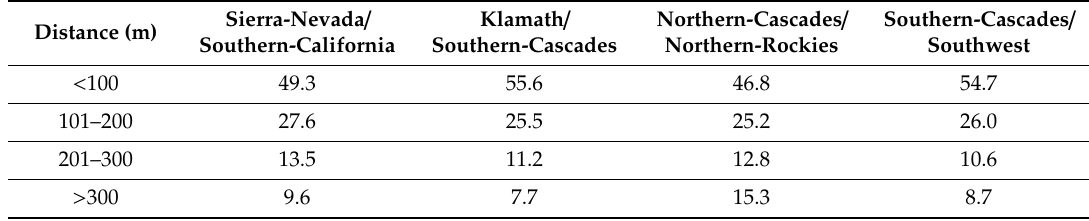
Figure 3. Scatter plot of size of individual large ( > 400 ha) CESF patches, 1984–2015. Table 2. Critical values (q 0.05, 4 ), absolute difference between mean of ranks. (| A - B |), standard errors (SE), and test statistics (Q) to assess statistical significance at α = 0.05 of any differences among the four-time groups (1 = 1984–1991, 2 = 1992–1999, 3 = 2000–2007, and 4 = 2008–2015) for the size of individual CESF patches >400 ha using the Dunn non-parametric test for multiple comparisons. The statistical significance of levels of Q are shown as “Y” (significant) or “N” (not significant). For time groups 1, 2, 3, and 4, n = 17, 46, 134, and 130 CESF patches >400 ha, respectively. Table 4. Percentages of the total area within the boundaries of CESF patches > 400 ha, created by high-severity fire, that were at increasing distances from unburned or low / moderate-severity edges and